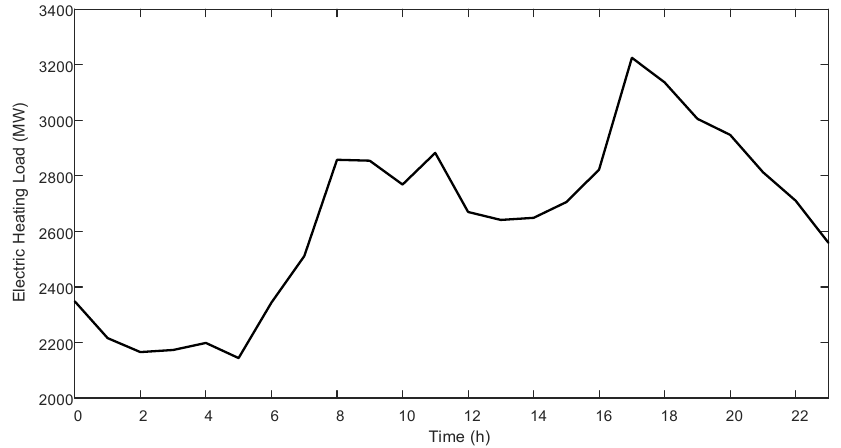
Figure 1. Typical electric heating load curve of a coal to electricity area in eastern Inner Mongolia.